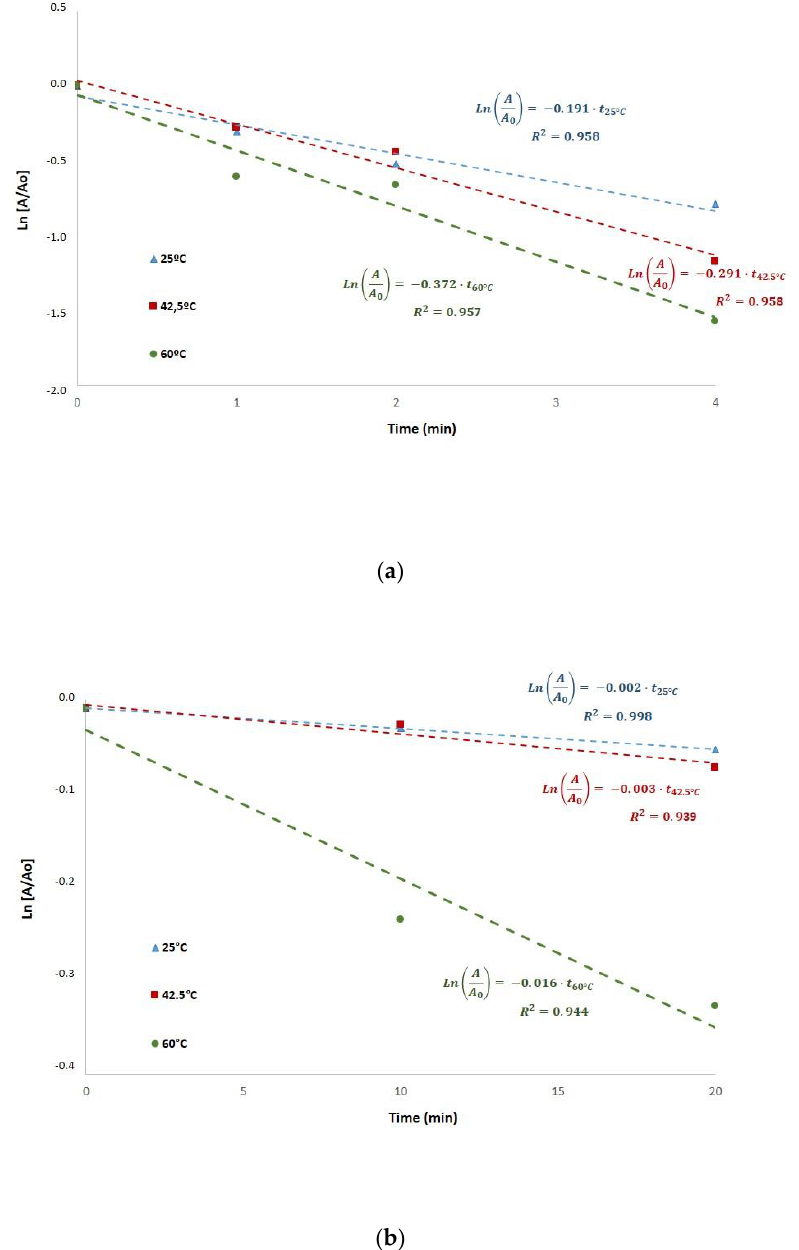
Figure 3. First order inactivation kinetics of myrosinase during blanching with ( a ) and without ( b ) ultrasound assistance. A is enzyme activity, A 0 is enzyme activity at time = 0, t T is time (min) of blanching at different temperatures, and R 2 is the determination coefficient.